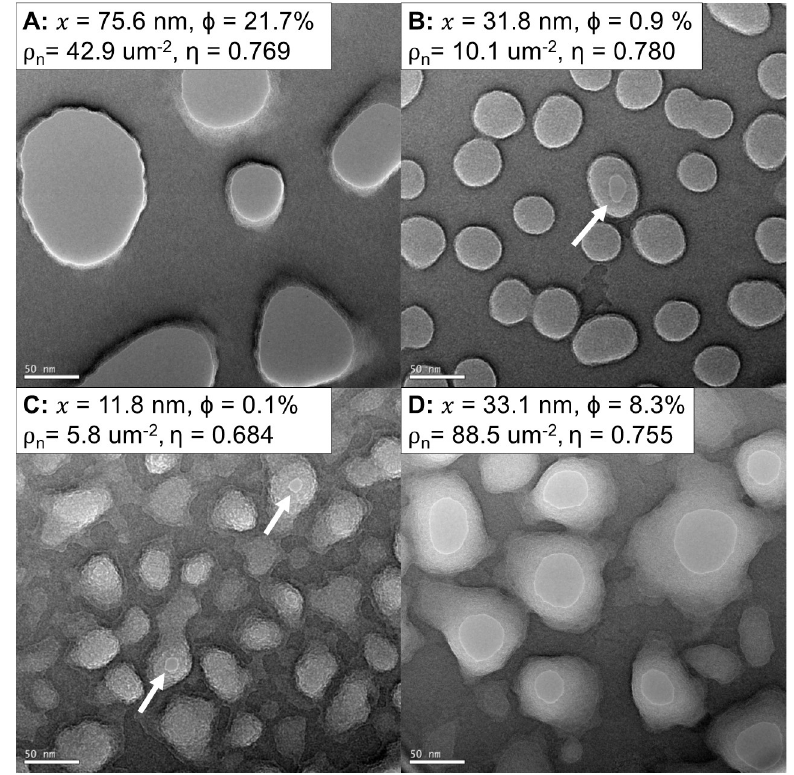
Figure 2. NPN membranes manufactured with different nanomorphologies. ( A – D ) TEM images (63 kx, 0°) of four different varieties of NPN. The sizes and shapes of the pores can range from largely open ( A , D ) to pitted and under-etched ( B , C ). White arrows indicate open nanopores in low-porosity films. Parameters derived from histograms of counted pores (Supplemental Section S1) show the wide variety of membrane porosities and pore diameters. x = Average Pore Diameter, Φ = Porosity, ρ n = Pore Density, η = Circularity.